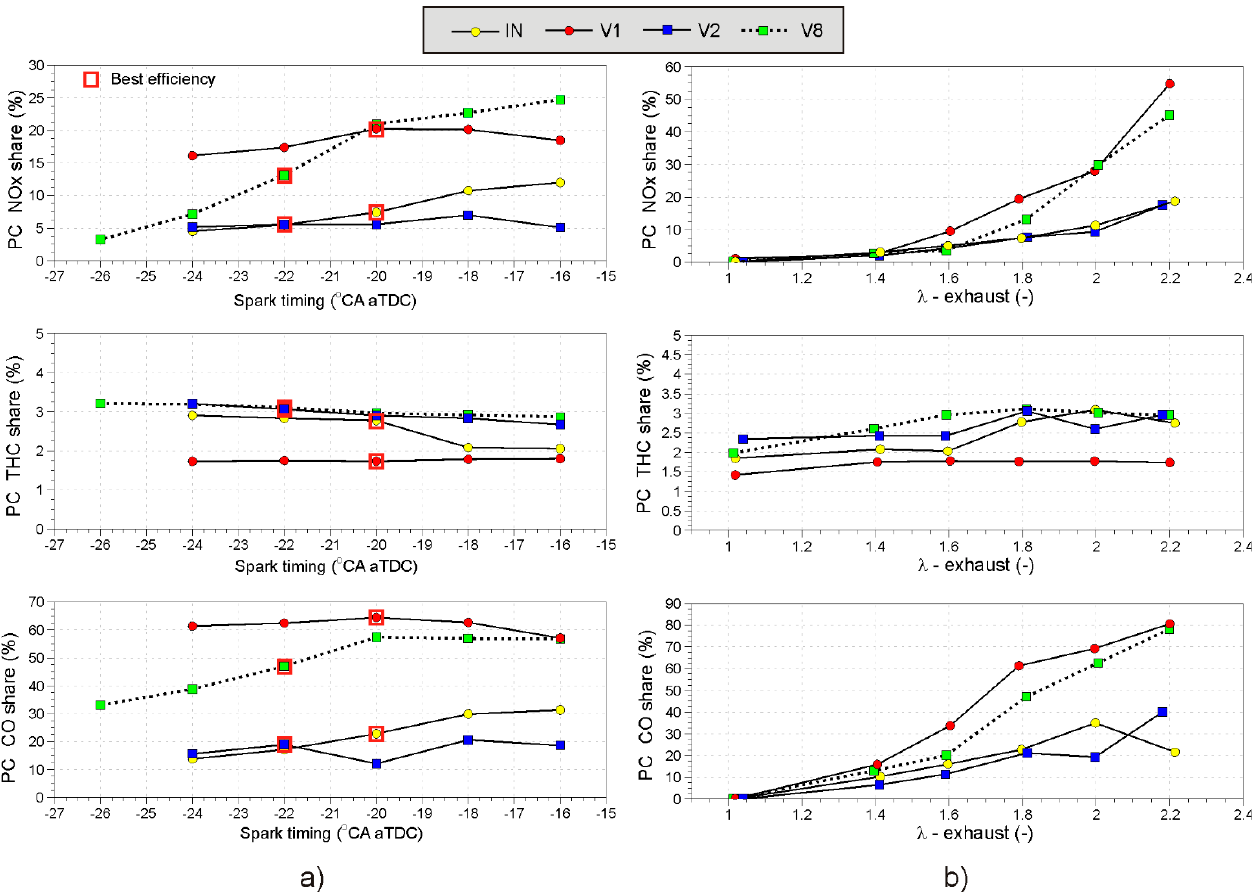
Figure 12. Pre-chamber emissions share evaluated from 1D/0D simulation model for different pre- chamber variants: ( a ) influence of spark sweeps at exhaust lambda equal to 1.8; and ( b ) influence of exhaust lambda sweep.